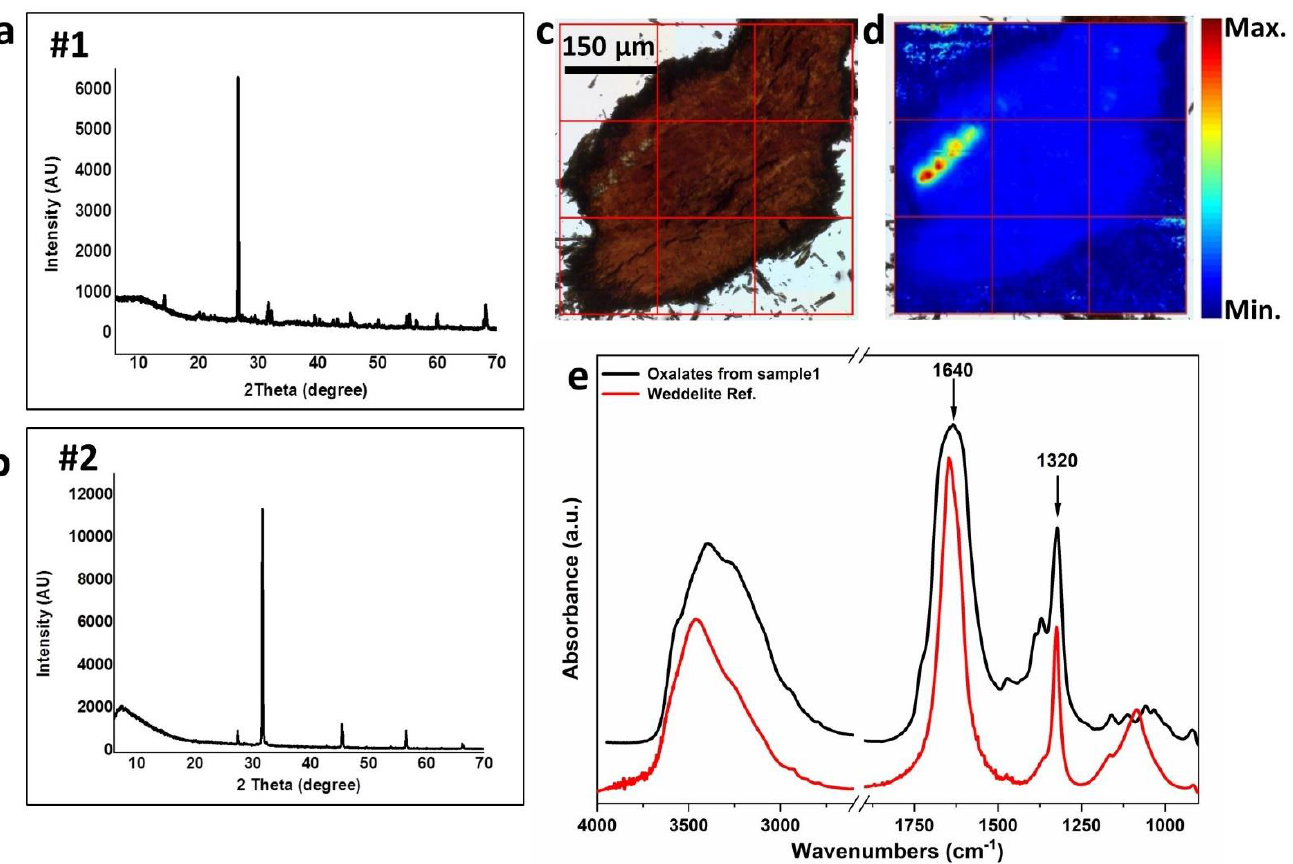
Figure 4. ( a , b ) XRD patterns of wood samples #1 and #2 of the archaeological statue, respectively, with a 2Ѳ value (2 Theta) from 5 ◦ to 70 ◦ . ( c ) Optical image of the sample #1. The red grid represents the area measured by Infrared focal plane array (FPA) detector shown then in panel d. ( d ) False-colour map of the sample #1 obtained by integrating the oxalate band in the 1350–1300 cm − 1 range (see panel e). This map highlights the distribution of oxalates within the sample #1 (blue corresponds to lowest amount, red to the highest one, see the colour bar aside for reference). ( e ) Average spectrum of oxalates (black line) extracted from the hot spots (bright red) highlighted in the false-colour FPA map in panel d. It is compared with a weddellite reference spectrum (Weddelite ref., red line) obtained from the Kimmel Center for Archaeological Science Infrared Standards Library,